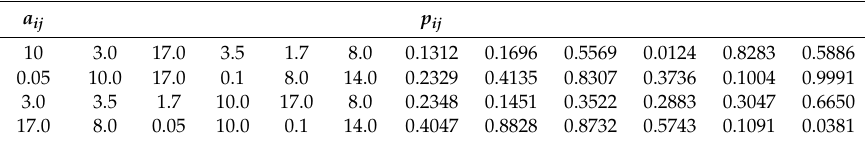
Table A2. Parameters used in Hartman function (6-D), j = 1, 2, ... ,